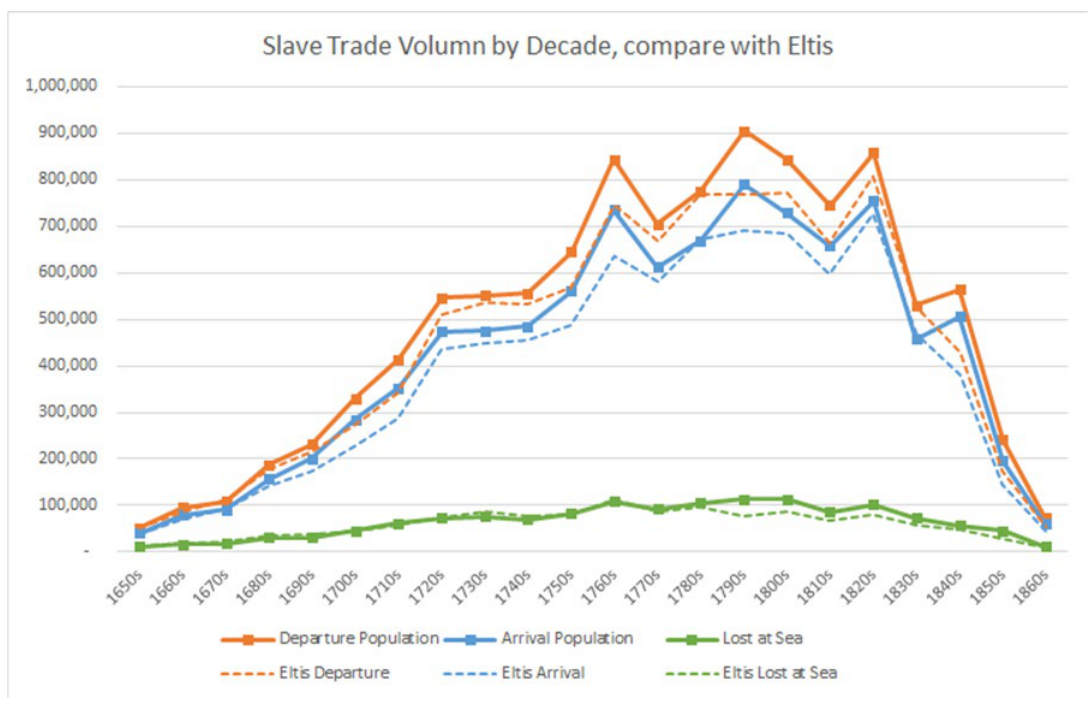
Figure 5. Overall estimation of Atlantic slave trade